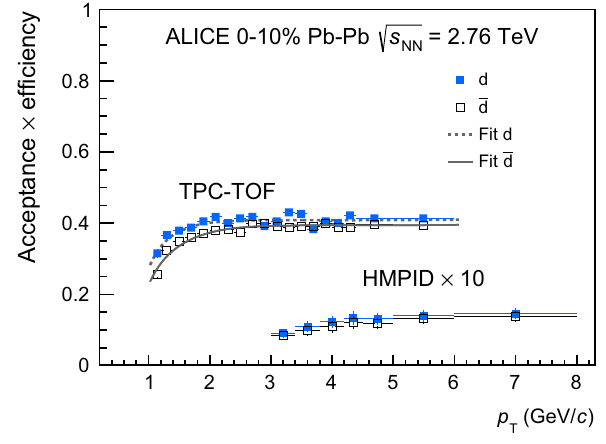
Fig. 2 Acceptance × efficiency (A × ε ) as a function of transverse momentum for deuterons (filled markers) and anti-deuterons (open √ s NN = 2.76 markers) in the most 10% central Pb–Pb collisions at TeV for TPC-TOF and HMPID (multiplied by a scaling factor) analy- ses. The TPC-TOF points account for tracking, matching efficiency and geometrical acceptance. The dashed and solid curves represent the fits with the function presented in Eq. 5 for deuterons and anti-deuterons respectively (see text for details). The HMPID points take into account tracking efficiency, geometrical acceptance, ε dist (“distance correction factor” as explained in the text) and PID efficiency. The lower value with respect to the TPC-TOF is mainly due to the limited geometrical acceptance of the HMPID detector